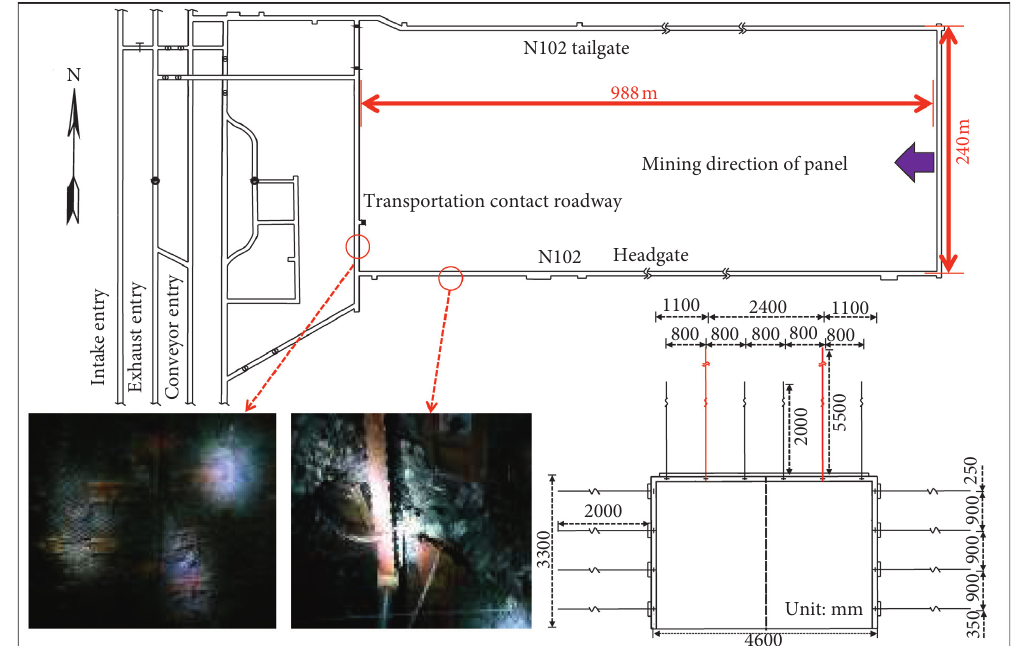
Figure 11: Location of test roadway.